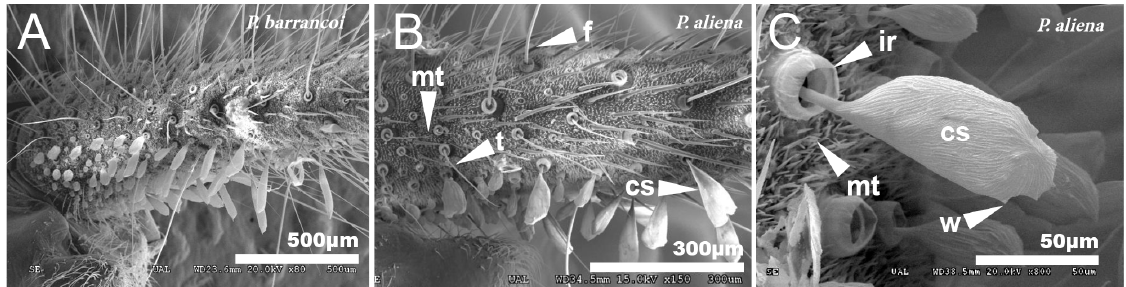
Figure 10. Cerci. SEM pictures showing the surface of the cerci of P. barrancoi ( A ) and P. aliena ( B , C ). The surface is covered with setae of different typologies: cs, globose setae; ir, internal ridge of globose setae; f, filiform setae; mt, microtrichia, t, tricoidsetae; w, crest.